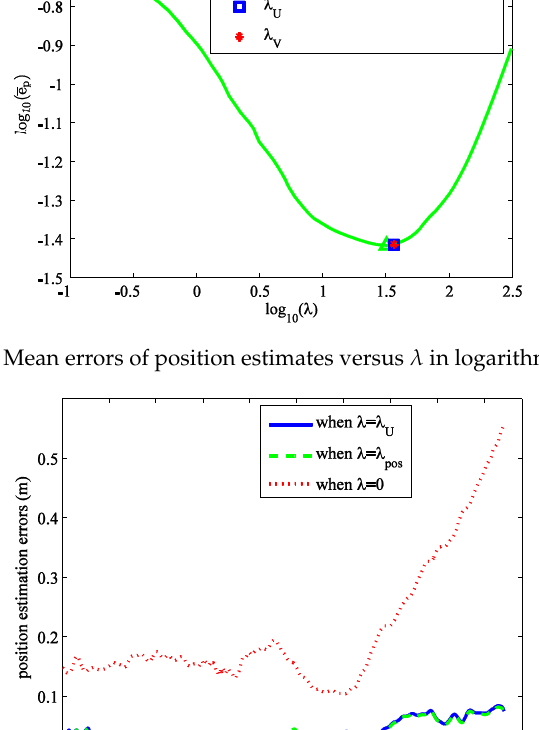
Figure 4. Errors of position estimates versus time when λ = λ U , λ pos , and 0.